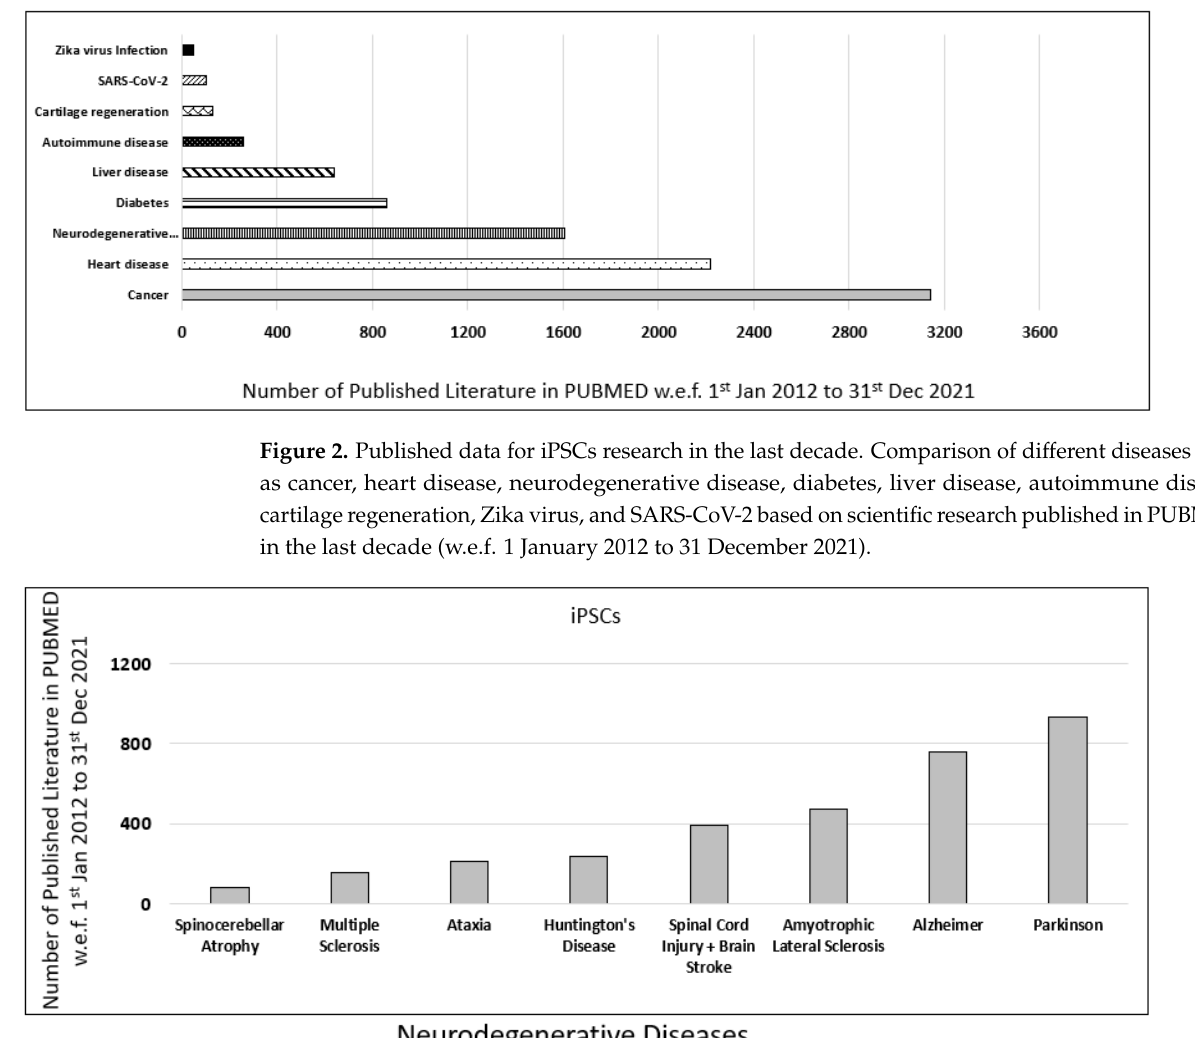
Figure 3. Published data for iPSCs research in the last decade. Comparison of different neurodegen- erative diseases such as spinocerebellar atrophy, multiple sclerosis, ataxia, spinal cord injury (SPI), Huntington’s disease, amyotrophic lateral sclerosis (ALS), Alzheimer’s disease (AD), and Parkinson’s disease (PD), based on scientific research published in PUBMED in the last decade (w.e.f. 1 January 2012 to 31 December 2021).